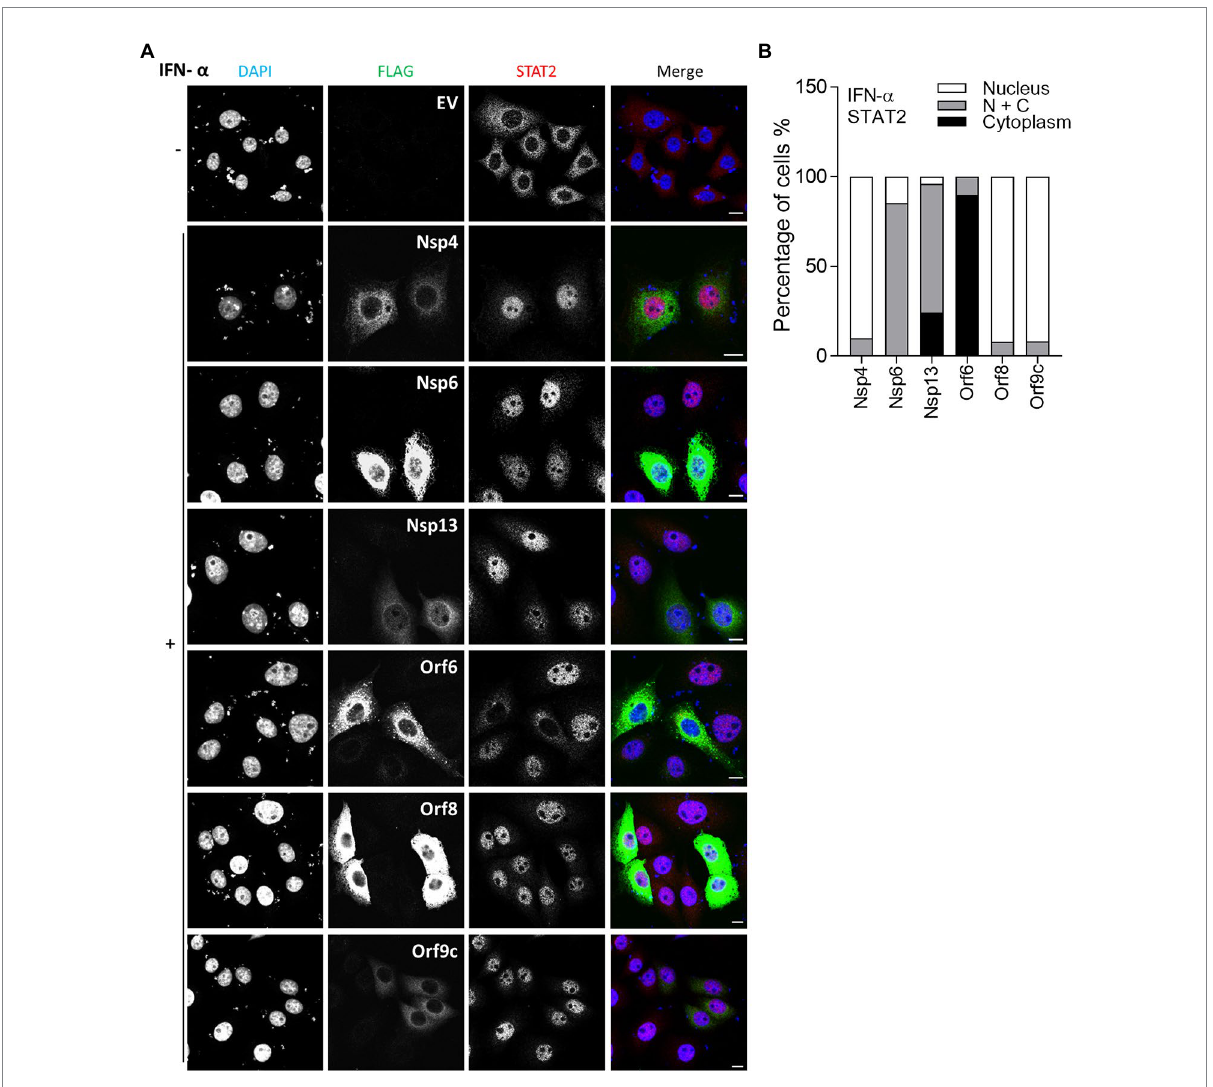
FIGURE 2 Immunofluorescence microscopy (IF) analysis of the effect of SARS-CoV-2 proteins on IFN- α induced STAT2 relocalisation. (A) HeLa cells were transfected with plasmids expressing the indicated SARS-CoV-2 proteins. After 12 h, transfected cells were stimulated with 1,000 unit/ml IFN- α for 1 h. The cells were then fixed, permeabilised and stained for STAT2, FLAG-tagged viral proteins and DNA with DAPI. The images are representative of the cell population. Scale bar, 10 μ m. (B) Quantification of IFN- α -induced redistribution of STAT2 in viral proteins expression cells ( n ≥ 20 in each condition). N + C represents staining within both the nucleus and